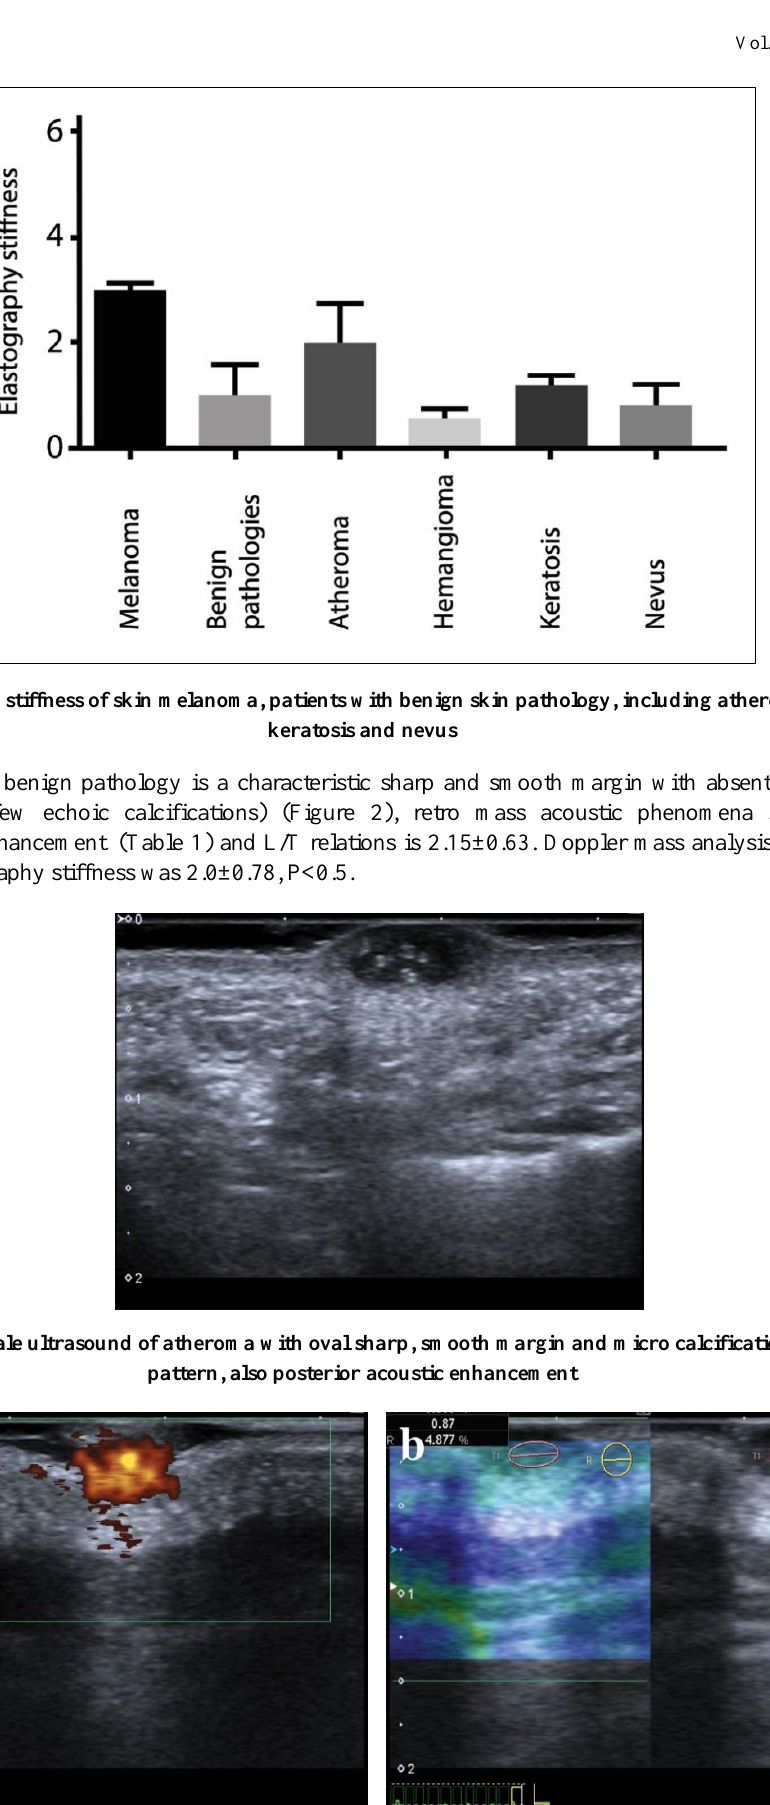
Figure 3. Power Doppler and of hemangioma showing hyper vascularization of the mass (a) also noted in melanoma, in the meantime the Elastography (b) stiffness ratio is much lower –